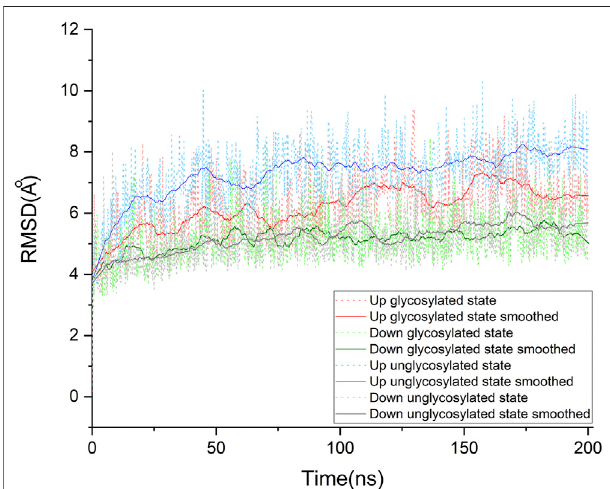
FIGURE 2 | C α root-mean-square deviation (RMSD) of the molecular dynamics simulations for our four systems. Each system was studied extensively by running three times ofmoleculardynamic simulations. For each protein system, only one of the simulations was taken out to make this plot representative. The raw data of RMSDs are shown in dot lines, and the fl uctuations of RMSD are smoothed by using the Savitzky-Golay method in OriginPro, version 2020 (OriginLab Corporation, Northampton, MA, and UnitedStates),withthepolynomialorderas1andpolynomialorderas50.The details for other trajectories are shown in supporting information (See S upporting Information. Supplementary Figure S2 ). All systems show an RMSD variation around 3 ∼ 4 Å, which is contributed by the large conformational motion of fl exible loops of the spike protein. Compared with these “ down ” conformational states, these “ up ” conformational states show more obvious fl uctuations.